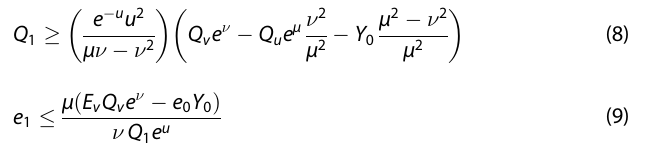
fi delity of 0.977